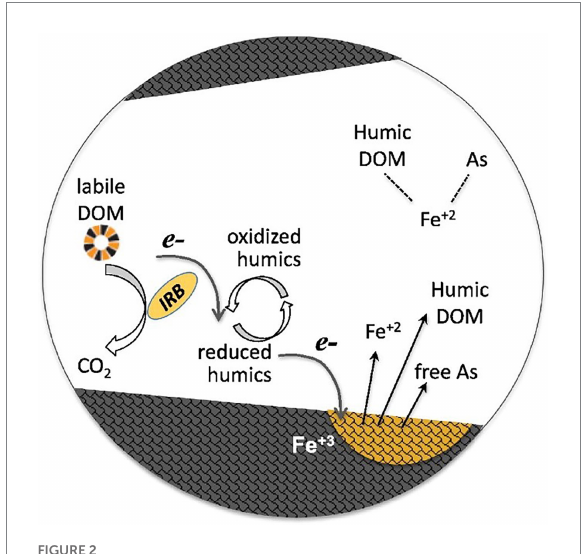
FIGURE 2 Conceptual model of humic dissolved organic matter (DOM) as an electronic shuttle that enhances the reductive dissolution of Fe(oxygen) hydroxide minerals (Kulkarni et al., 2018). Panels were obtained with the permission from